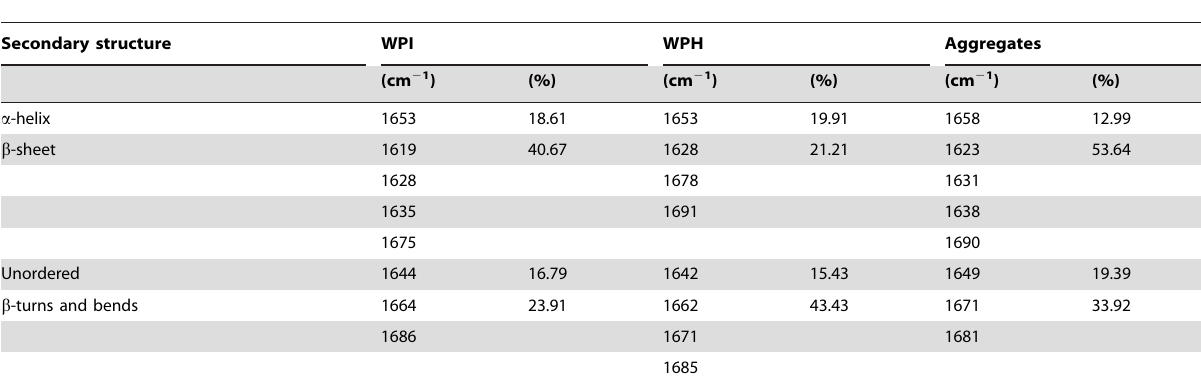
Table 2. Curve-fitting